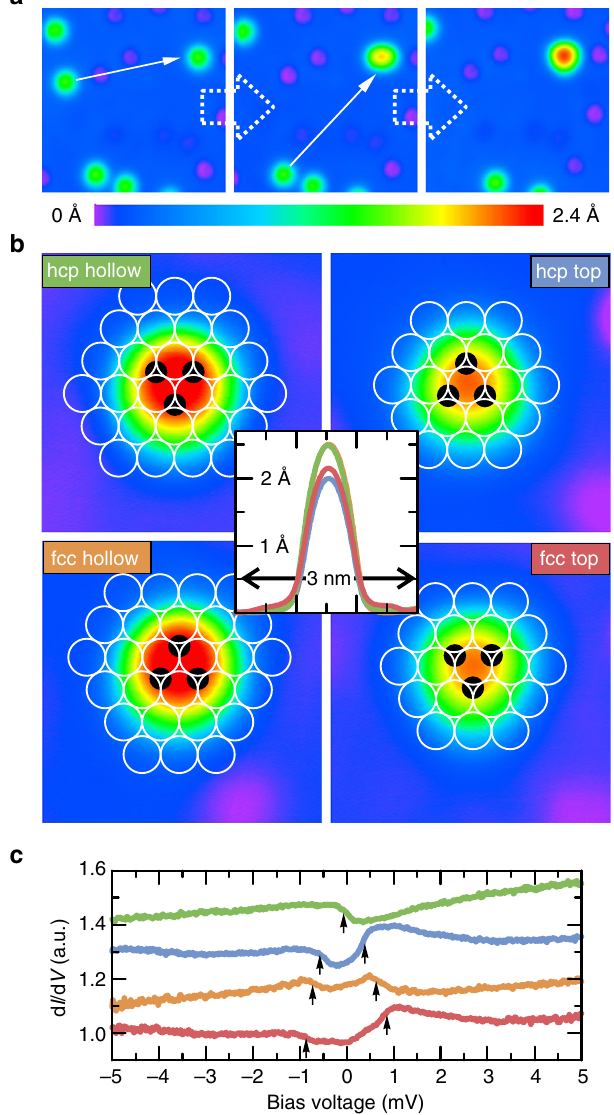
Fig. 1 Fabrication of the giant moment clusters. a Constant-current images taken during the fabrication of an Fe 3 cluster from three individual Fe atoms on Pt(111) (image sizes 5×5 nm 2 , V = − 5 mV, I = 500 pA). Left : the arrow indicates the fi rst manipulation step of one of the individual Fe atoms; Middle : a dimer has been formed, the arrow indicates the second manipulation step; Right : the Fe 3 cluster has been formed. b Constant-current images of the four possible Fe 3 cluster geometries (image sizes: 2×2 nm 2 , V = 5 mV, I = 500 pA). The open circles indicate the underlying lattice of surface Pt atoms and the black spheres the positions of the three Fe atoms within each cluster. A height pro fi le across the center of each of the individual clusters is indicated in the middle. c ISTS taken on the center of the hcp hollow ( green ), the hcp top ( blue ), the fcc hollow ( orange ) and the fcc top ( red ) cluster ( B = 0T, T = 0.3 K). The step-like features in each spectrum originating from the excitations of the clusters are indicated by